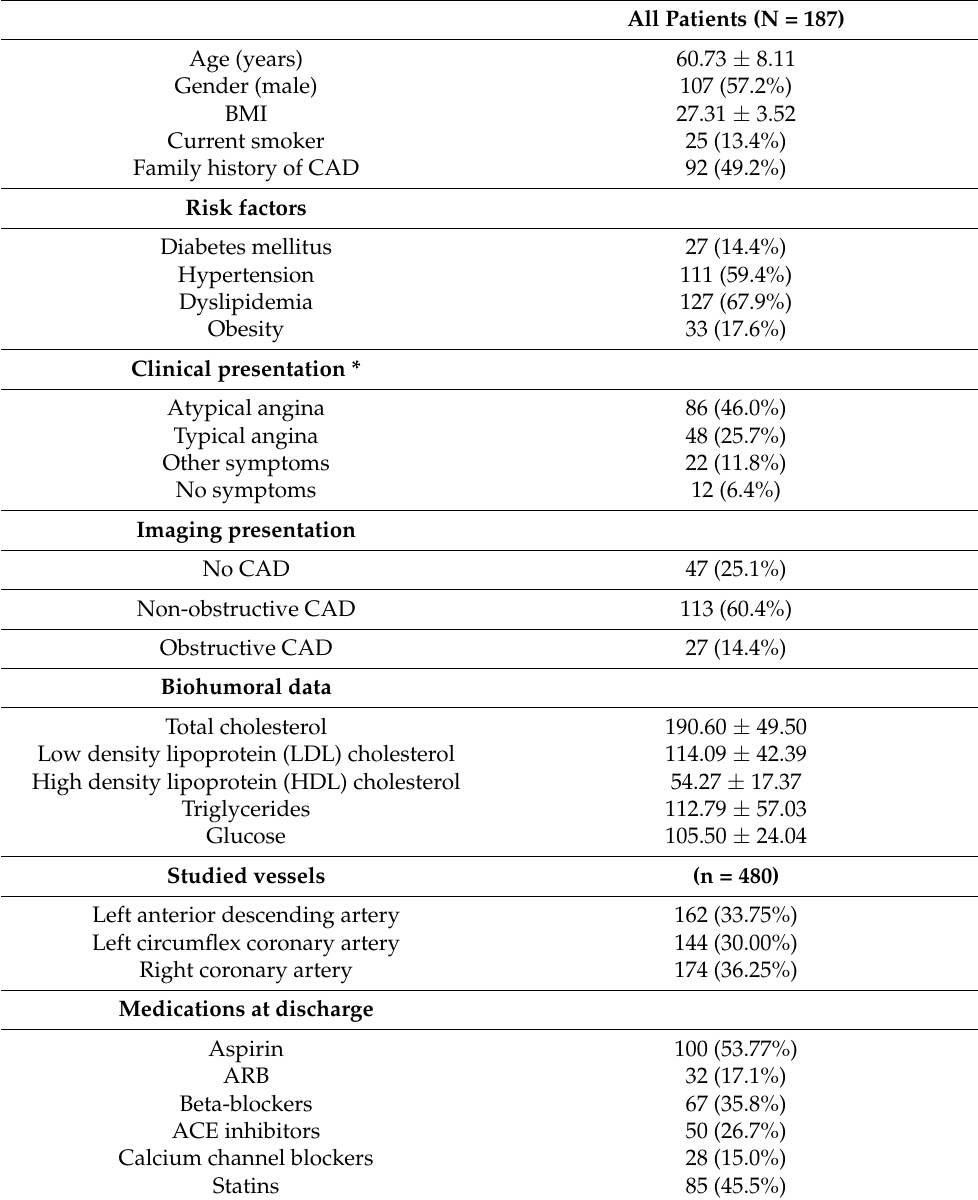
Table 1. Baseline demographics, clinical and biohumoral